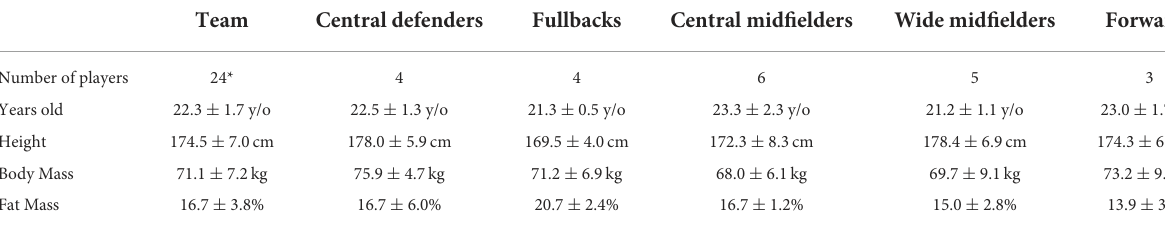
TABLE 1 Anthropometric data from the analyzed team. Team Central defenders Fullbacks Central midfielders Wide midfielders